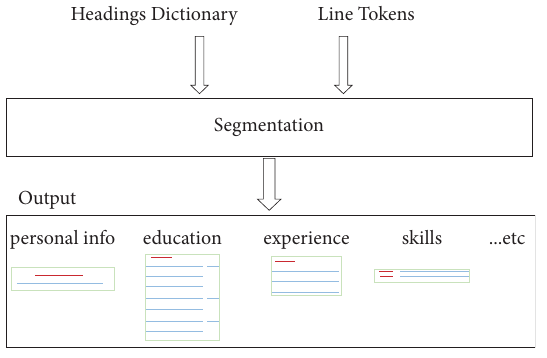
Figure 4: Segmentation